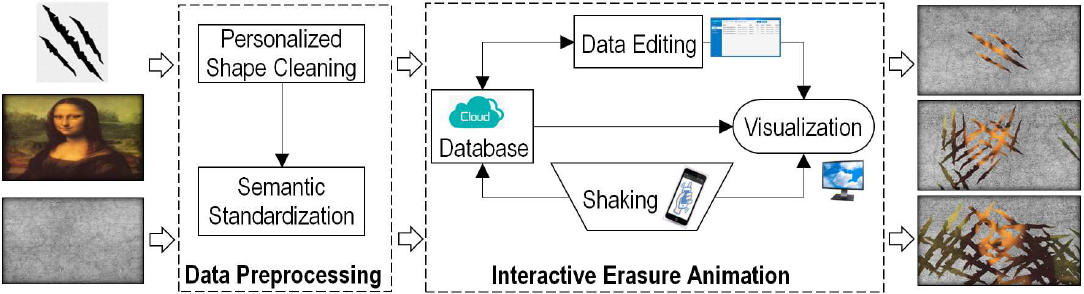
Figure 1. The framework of our